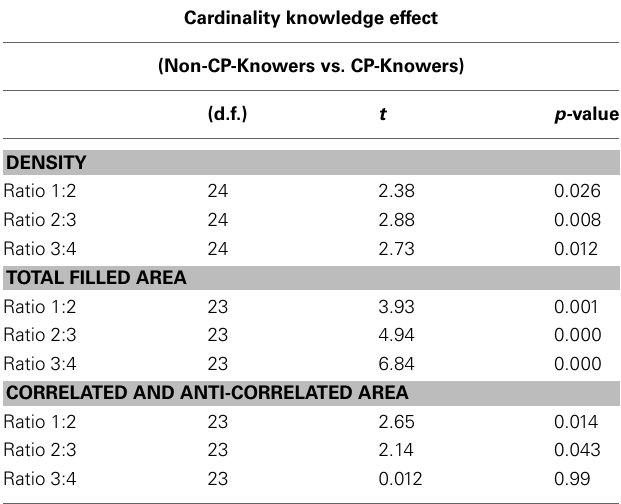
Table 3 | Statistics for the cardinality knowledge effect divided by visual control and